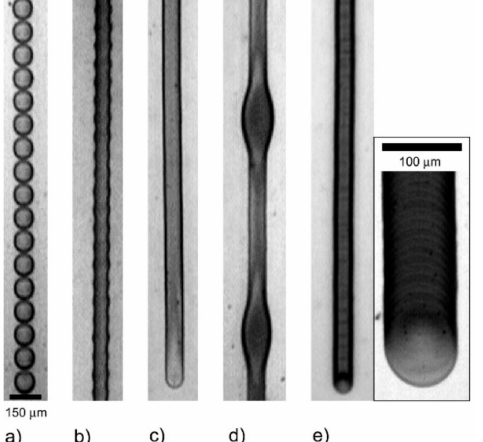
Figure 5. ( a – e ) Illustration showing the relationship between dot spacing and print morphology. Reprinted (adapted) with permission from [80]. Copyright (2019) American Chemical